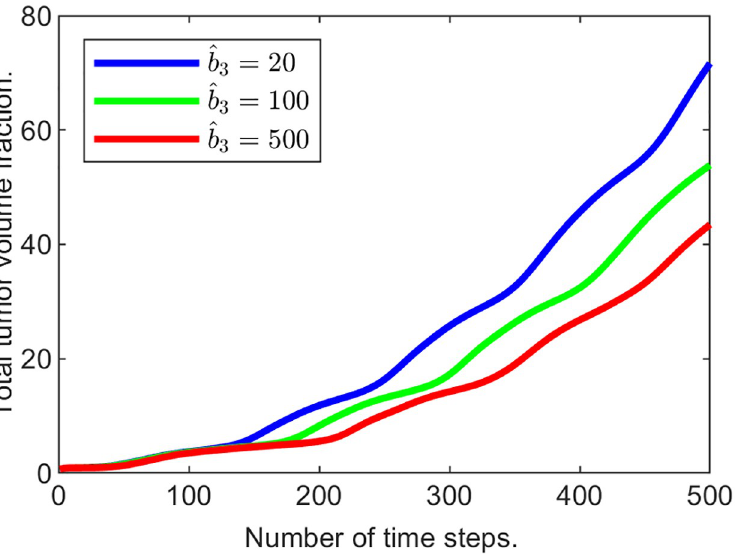
Fig 14. Tumor mass changing with time for various ECM remodeling coefficient